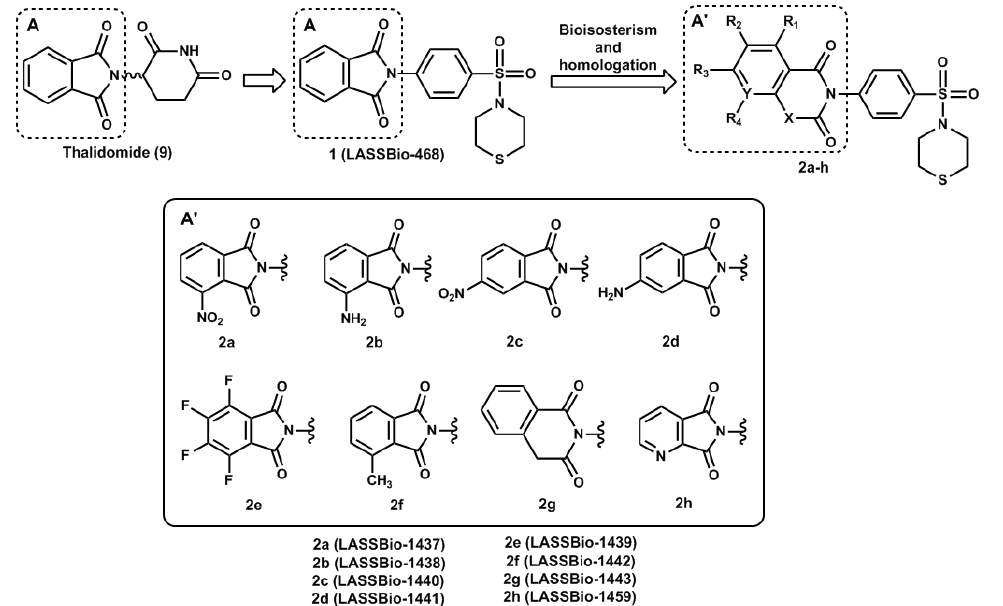
Scheme 1. Structural design of the target derivatives 2a – h